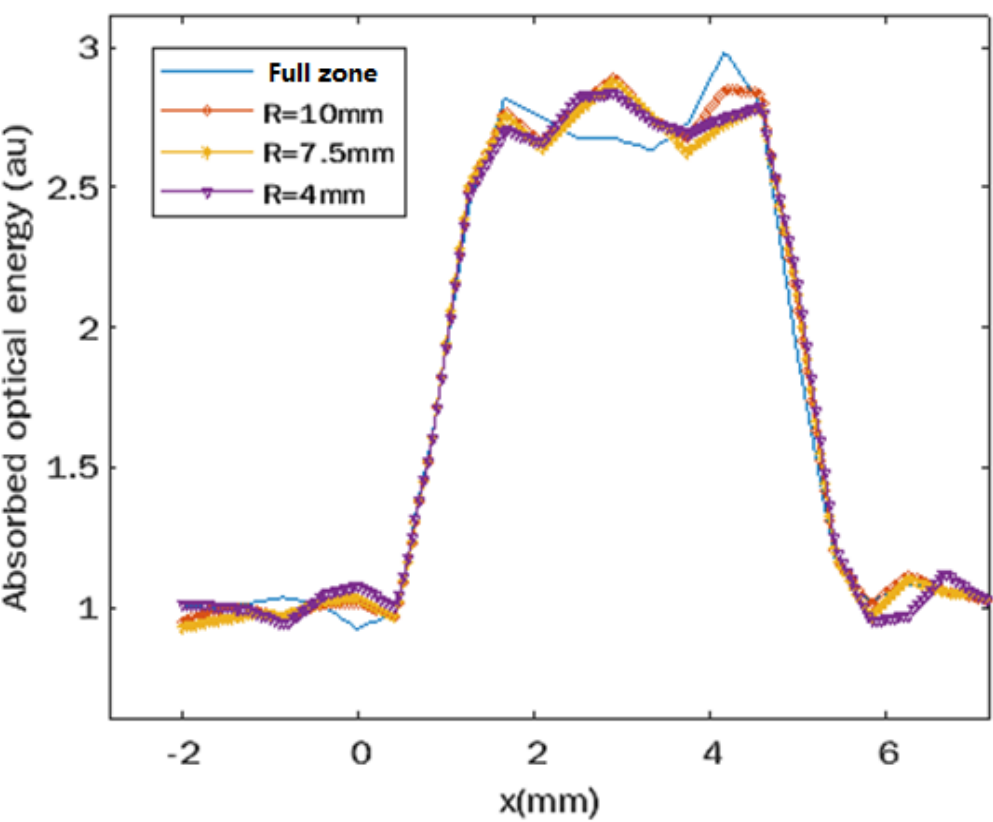
Figure 2. The comparison of reconstructed photoacoustic intensities (absorbed optical energies) across the center of the simulated target by using a full zone-based FE-PAT algorithm and localized FE-PAT algorithm in various ROI sizes (R = 10.0 mm, R = 7.5 mm and R = 4.0 mm). Table 1. Mesh parameters and performance comparison between conventional full zone-based FE-PAT algorithm and localized FE-PAT algorithm in various ROI sizes for simulation